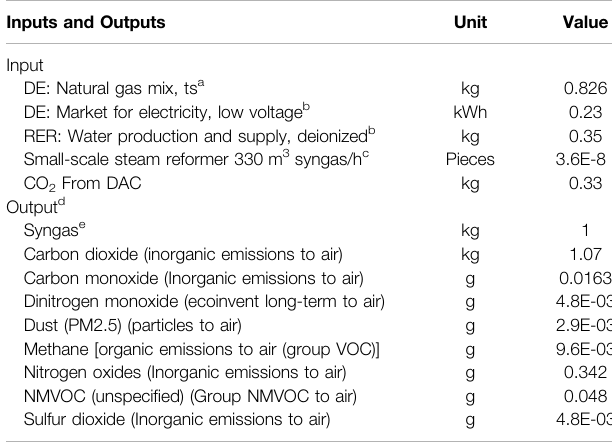
TABLE 2 | Operation of HT-co-electrolysis to produce 1 kg of syngas (molar ratio H 2 /CO (cid:1) 2) under consideration of different electricity mixes.